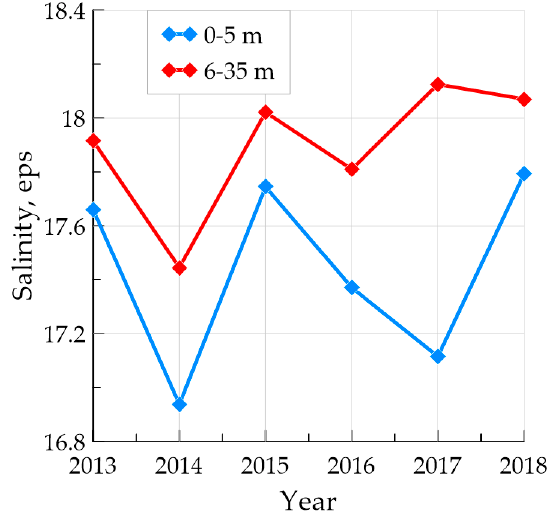
Figure 10. Changes in salinity in the layers of 0–5 m and 6–35 m within the period of 2013–2018 (from our field studies in June).